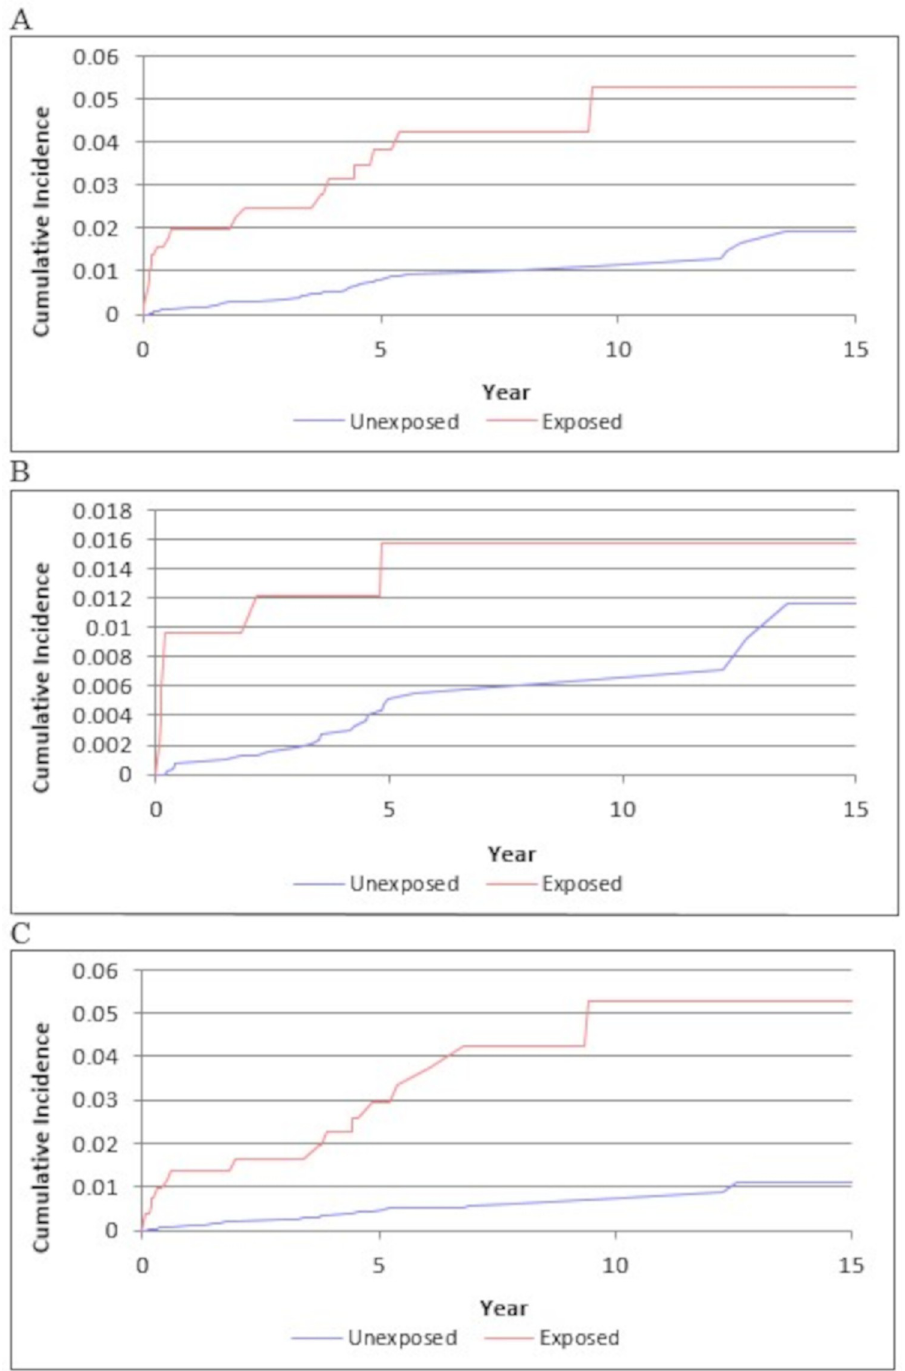
Fig 1. Risk-of-death-adjusted cumulative incidence of venous thromboembolism among granulomatosis with polyangiitis and non-granulomatosis with polyangiitis cohorts. (A) Venous thromboembolism. (B) Pulmonary embolism. (C) Deep vein